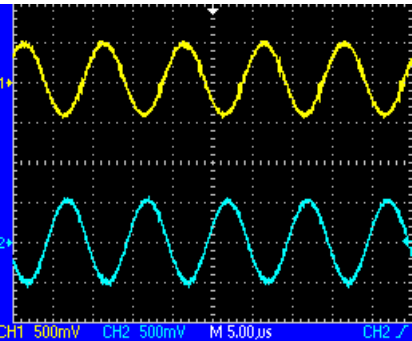
Figure 6. Resonant outputs of the coils with the opposite